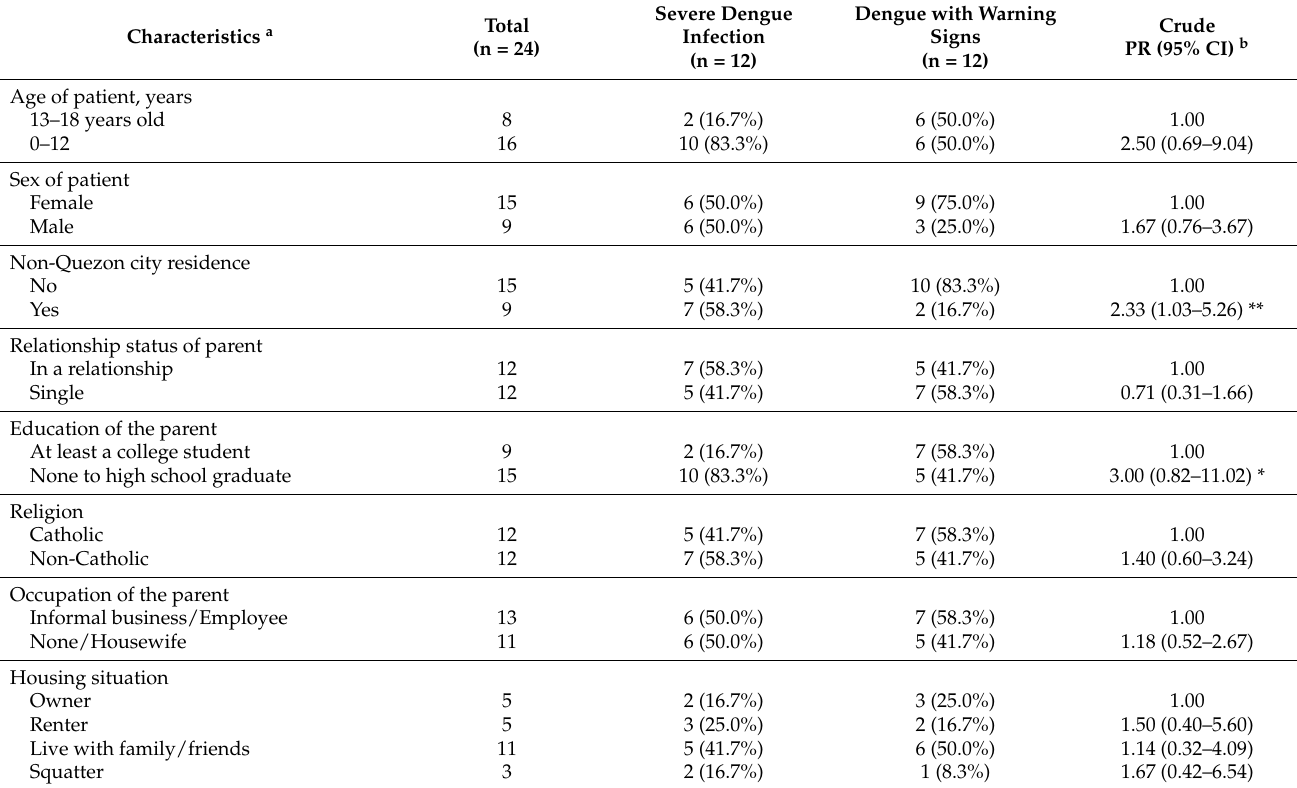
Table 2. Effect of the type of delay and socio-demographic characteristics on the severity of dengue infection of patients admitted at NCH (n =